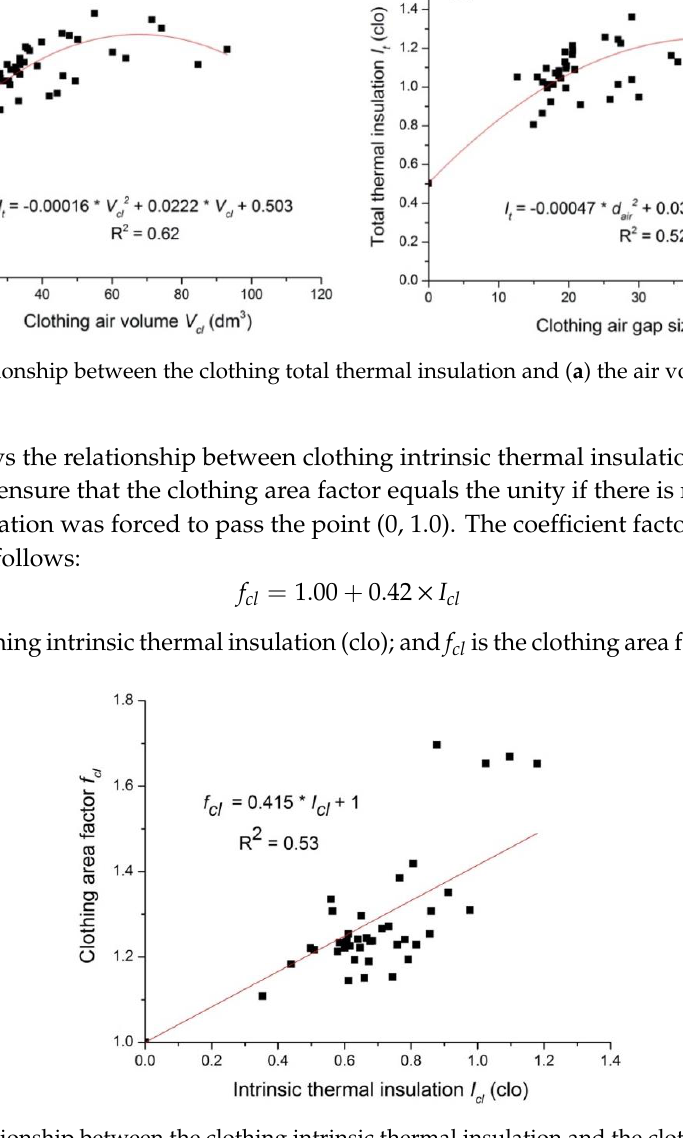
Figure 3. Relationship between the clothing intrinsic thermal insulation and the clothing area